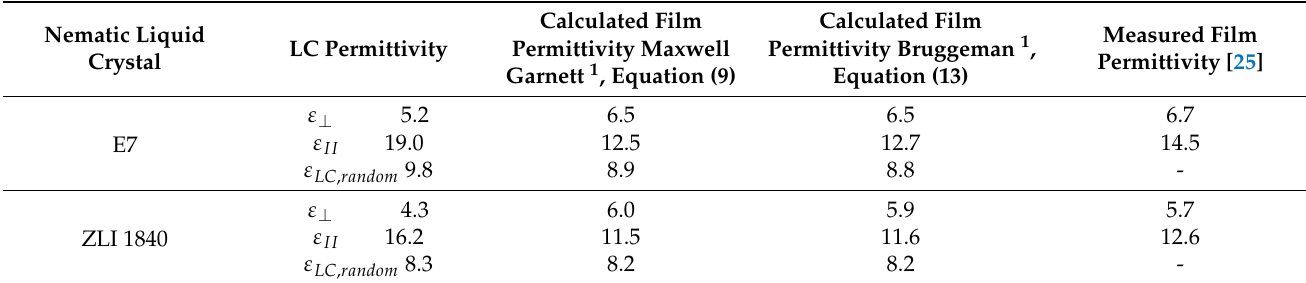
Table 1. Comparative presentation of calculated PDLC film permittivity using Maxwell Garnett (Equation (10)) and Bruggeman (Equation (14)) formulas, and experimental results [25]; the field permittivity measured at low electric field corresponds to ε ⊥ of the LC and at high electric field to the ε II of the LC (LC aligned in the direction of the field). Nematic Liquid